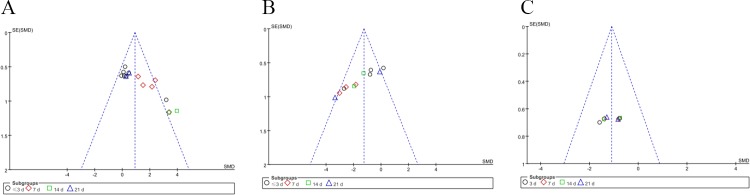
Funnel Plot of MDA (A), SOD (B) and GSH (C) Data. SE: standard error; SMD: standard mean difference.